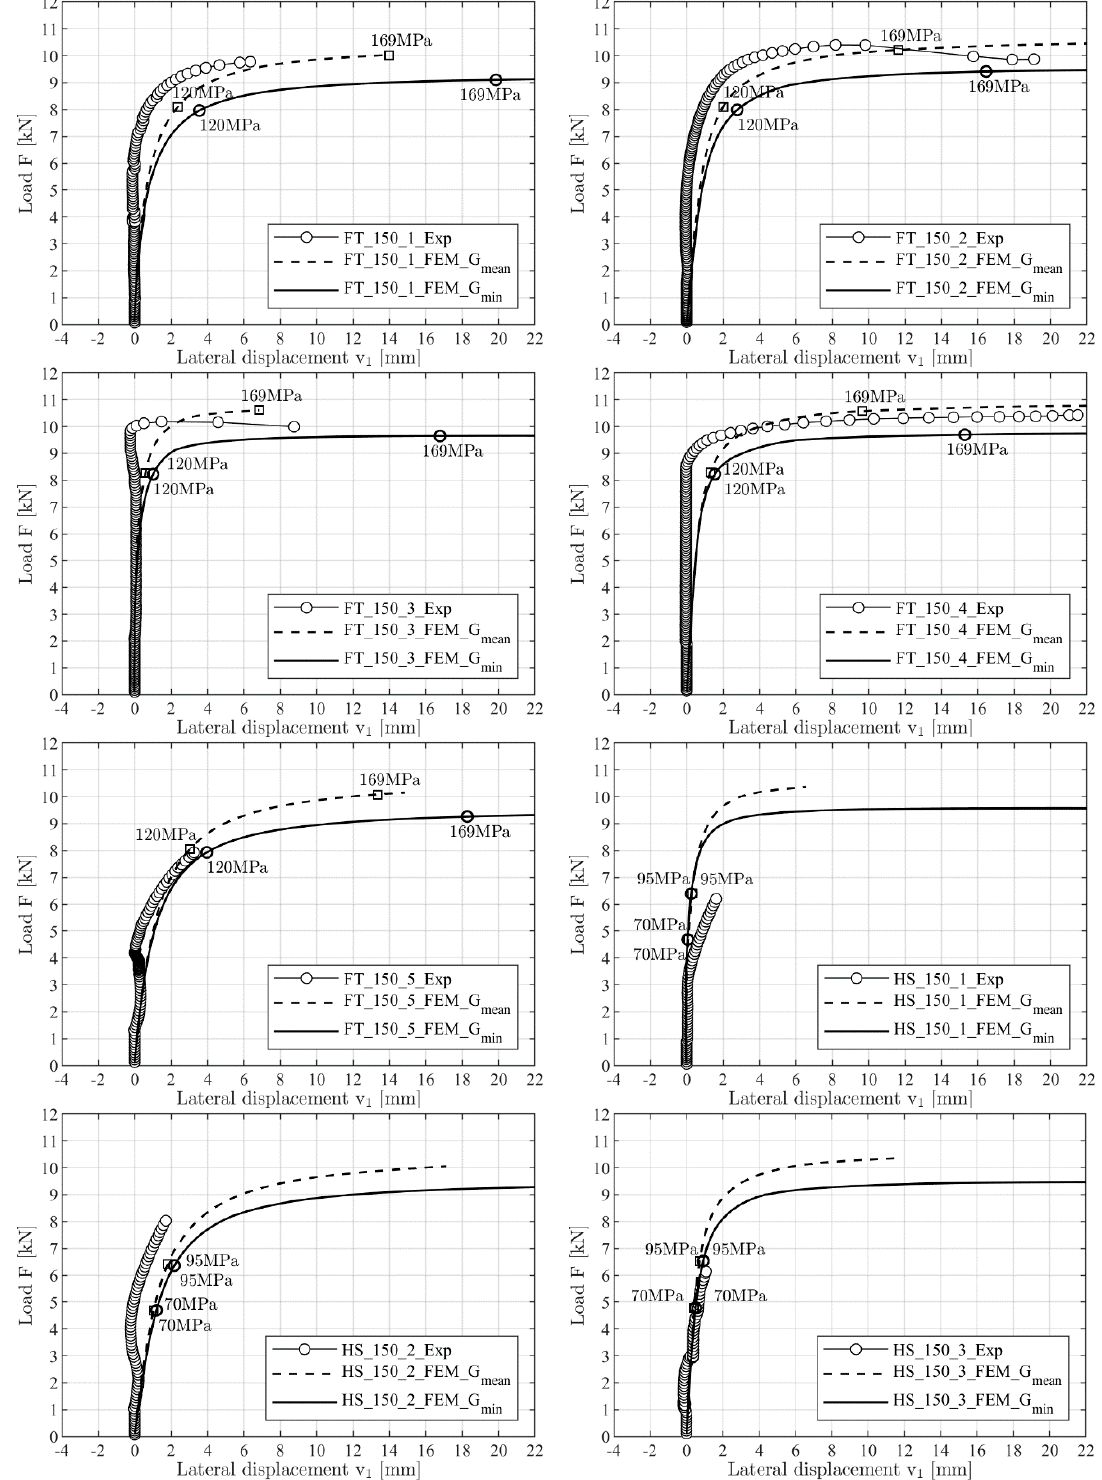
Figure 6. Experimental and numerical load-deflection curves (values obtained at the free end of the cantilever beam) from test specimens with a glass-height of 150 mm.